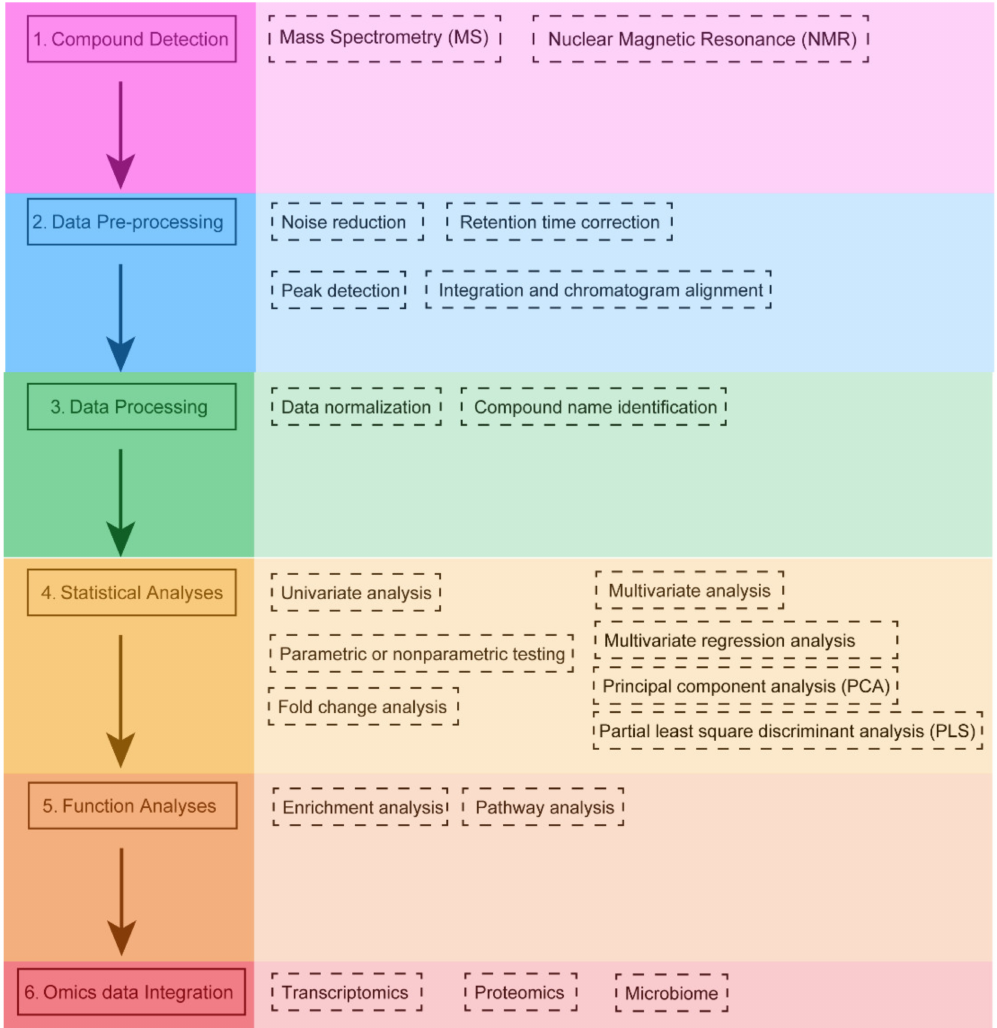
Figure 1. Typical workflow of metabolomics analysis. Metabolites are detected by using specific detection techniques (compound detection). Raw signals are then pre-processed to produce data in a suitable format for subsequent statistical analysis (data pre-processing). Then, data normalization is used to reduce the system and technical bias. For untargeted studies, metabolites are identified from spectral information in some given database (data processing). Univariate and multivariate statistical analyses are used to identify significantly expressed metabolites (statistical analyses). Next, the signif- icantly expressed metabolites are subsequently linked to the biological context by using enrichment and pathway analysis (function analyses). Finally, metabolomics data may be integrated with other omics data (transcriptomics, proteomics, or the microbiome) to gain a comprehensive understanding of the molecular mechanisms of pathophysiological processes (Omics data